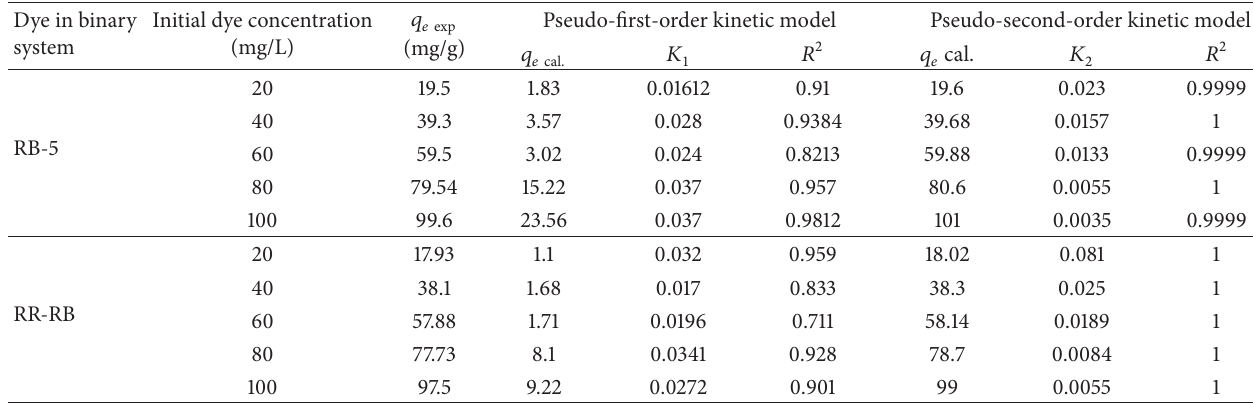
Table 5: Parameters and correlation coefficient ( 𝑅 2 ) for pseudo-first-order and pseudo-second-order kinetic models for adsorption RB-5 and RR-RB by QKCF in binary